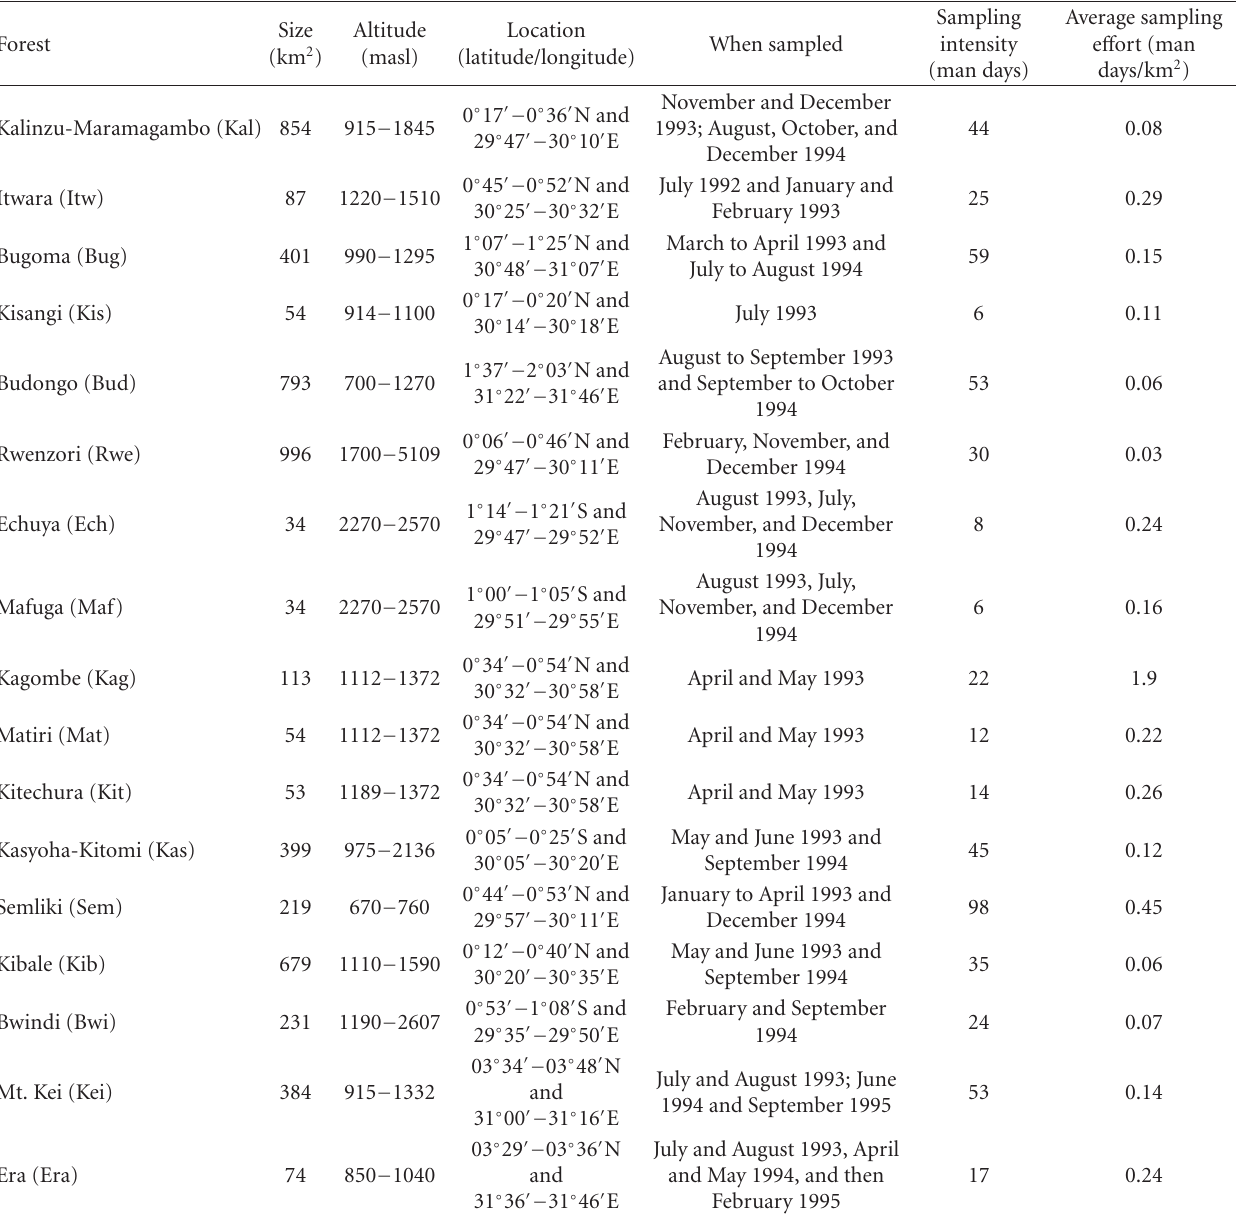
Table 1: Key characteristics of the study